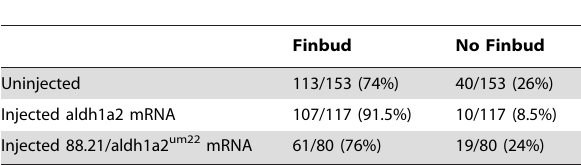
Table 1. Rescue 88.21 fin bud